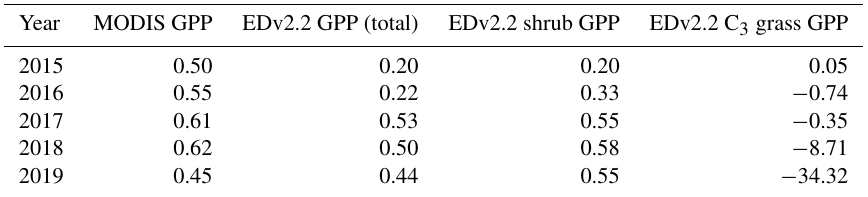
Table A1. Percent difference in GPP between burned and unburned areas ((GPP in unburned area − GPP in burned area) / GPP in unburned area) for pre-fire and post-fire